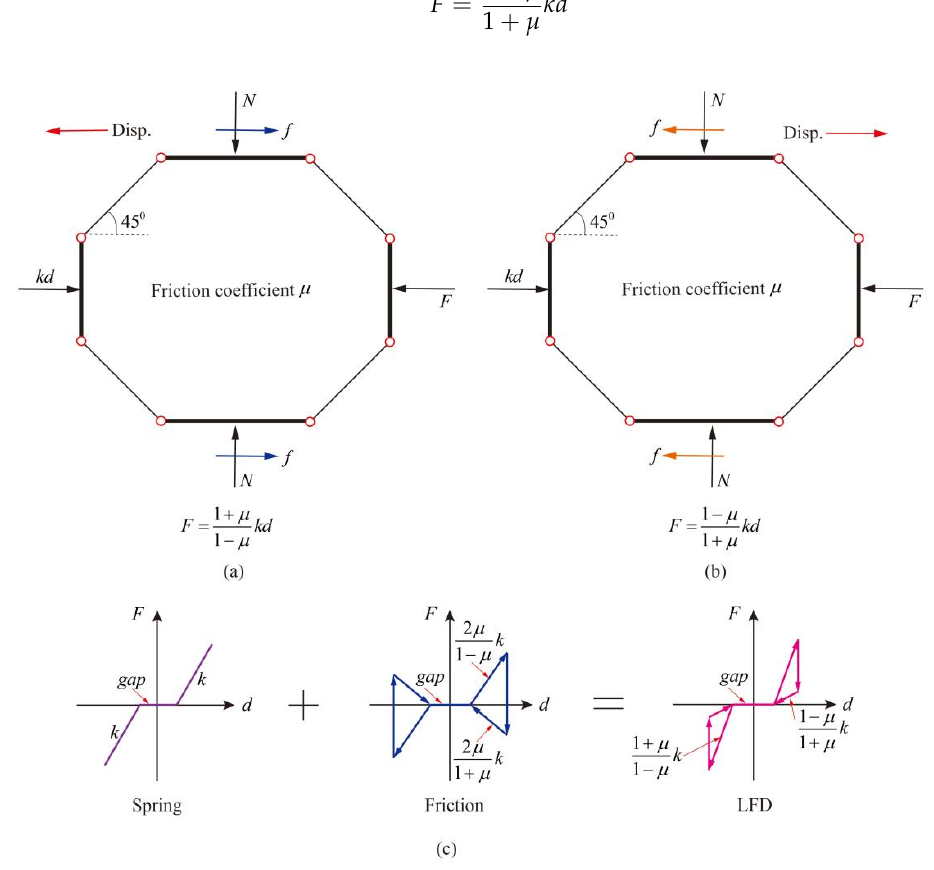
Figure 2. The working process of the LFD: ( a ) loading process; ( b ) unloading process; ( c ) constitutive